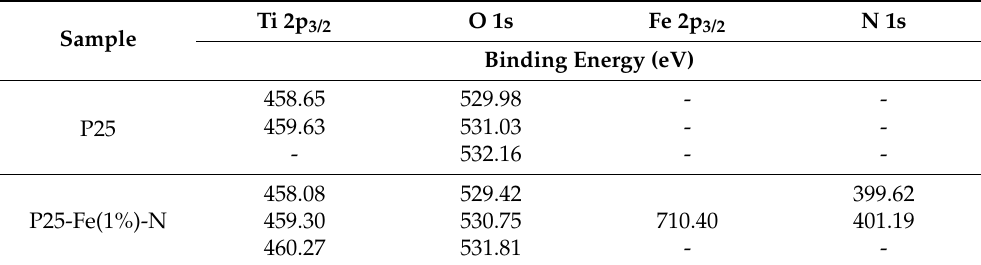
Table 2. The binding energy values extracted from the deconvolutions of the X-ray photoelectron spectroscopy (XPS) spectra of the P25 and P25 – Fe(1%)-N NPs samples.